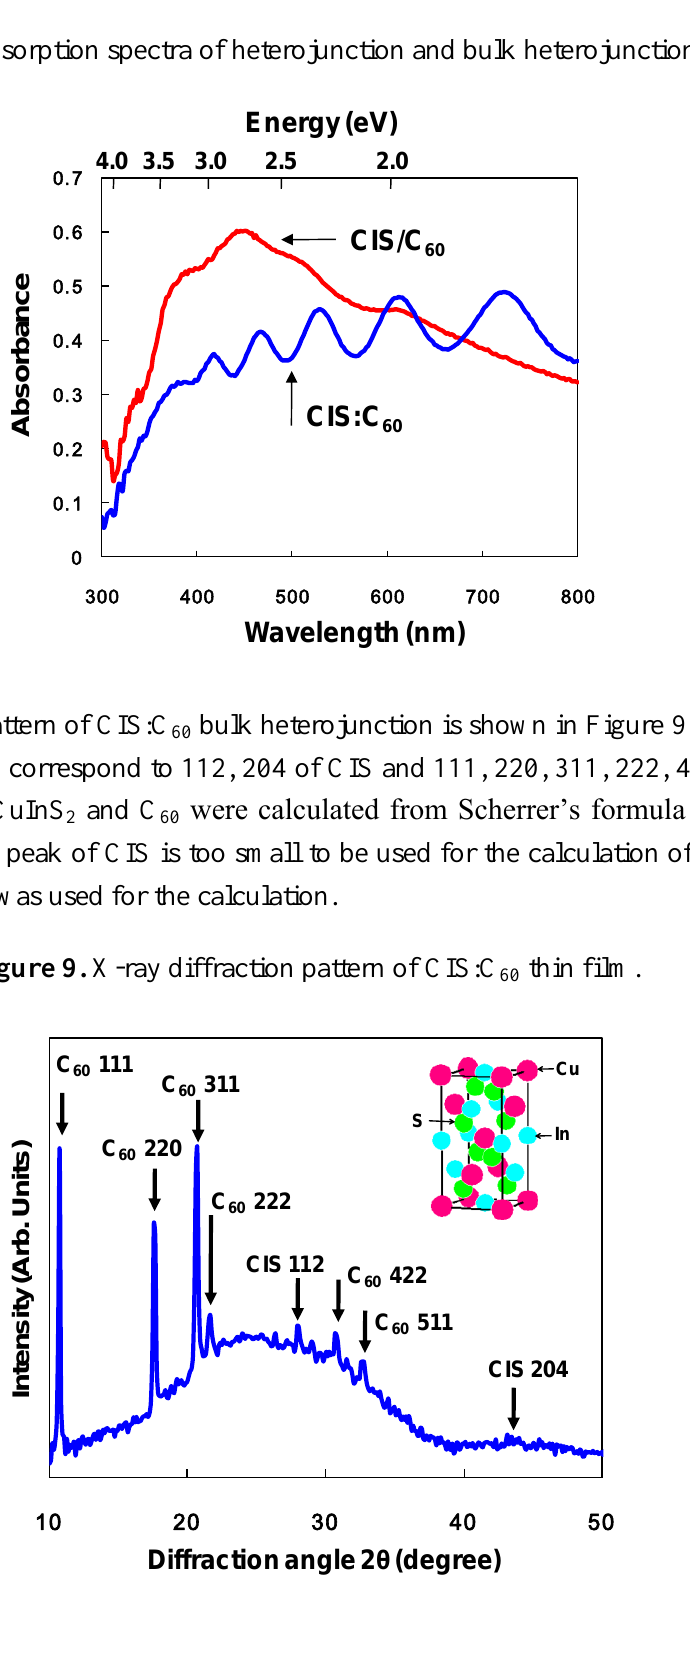
Figure 8. Optical absorption spectra of heterojunction and bulk heterojunction solar cells.